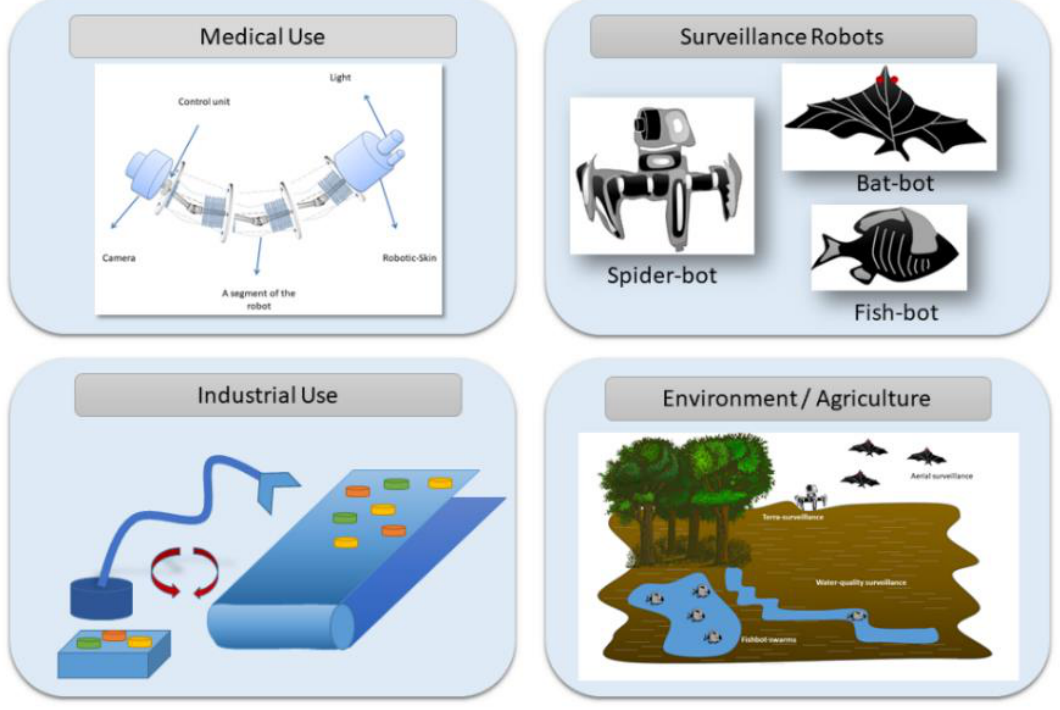
Figure 5. Conceptual illustrations of diverse applications for soft-actuators.